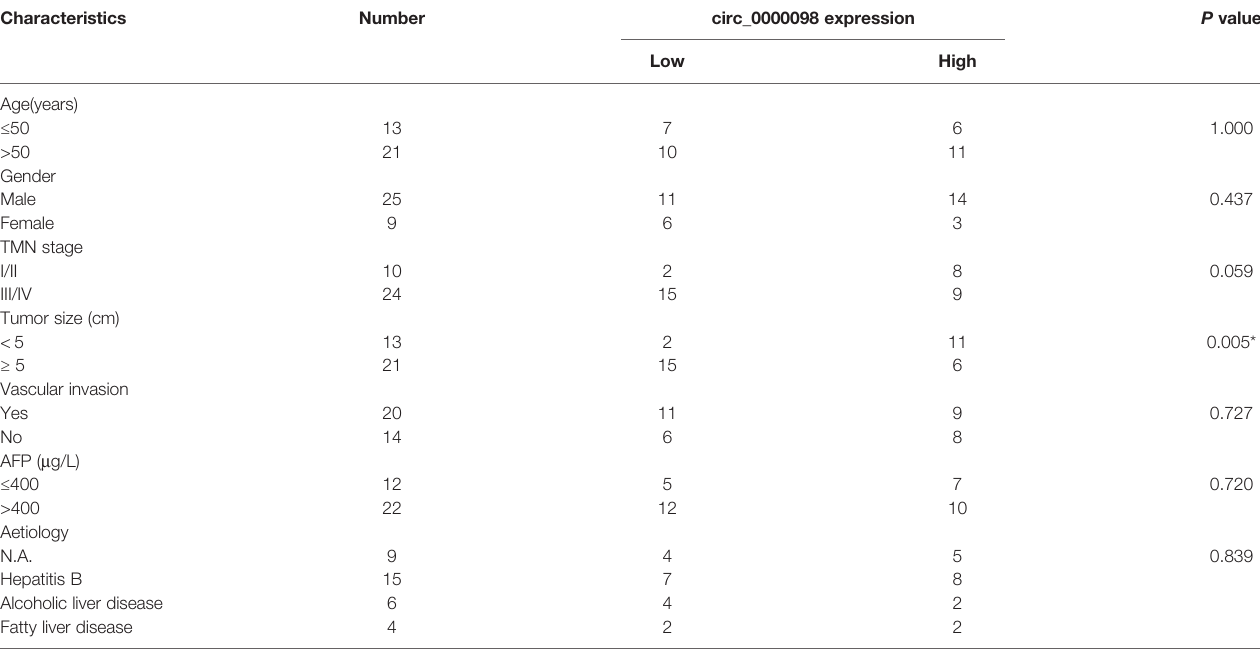
TABLE 2 | Correlation between circ_0000098 expression and clinicopathological features in 34 HCC patients.